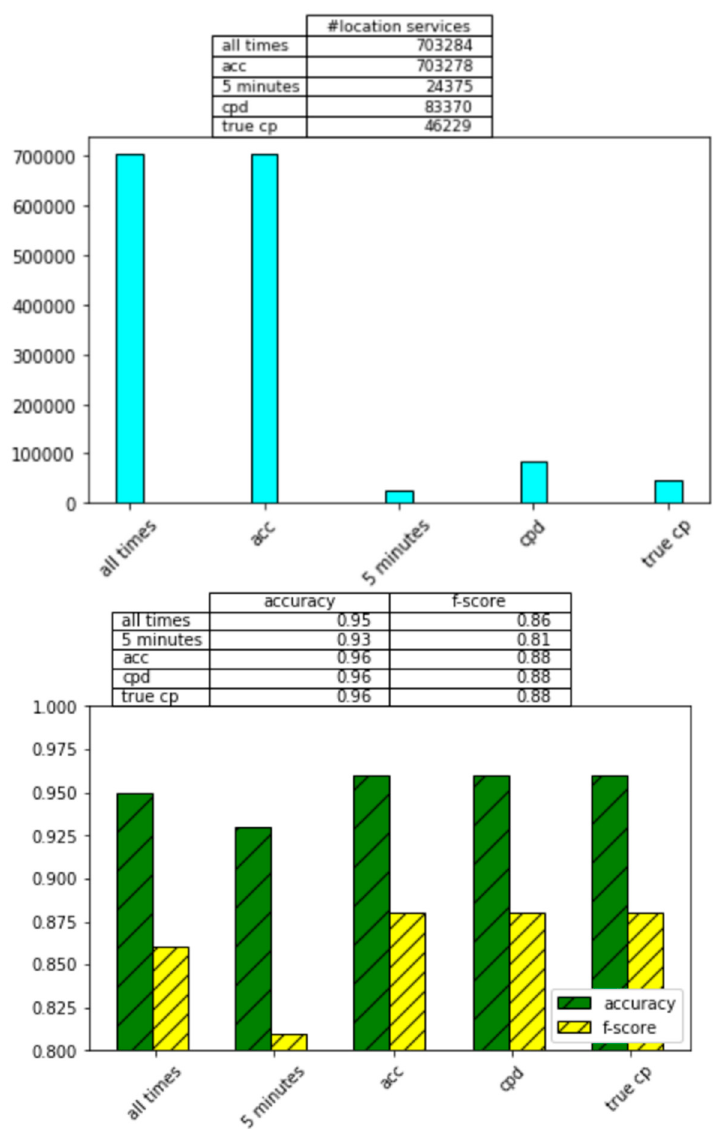
Figure 11. (top) Activity recognition accuracy for all times, acc, 5 min, CPD (CPAM), and true change point sampling strategies. The following accuracy and f-score differences are statistically significant. ( p < 0.05): acc and all times, acc and 5 min, CPD and all times, CPD and 5 min, true cp and all times, true cp and 5 min. The changes in activity recognition performance between acc, CPD, and true cp are not statistically significant. ( bottom ) The number of location samples that are collected for the all times, 5 min, acc, CPD (CPAM), and true cp sampling strategies.